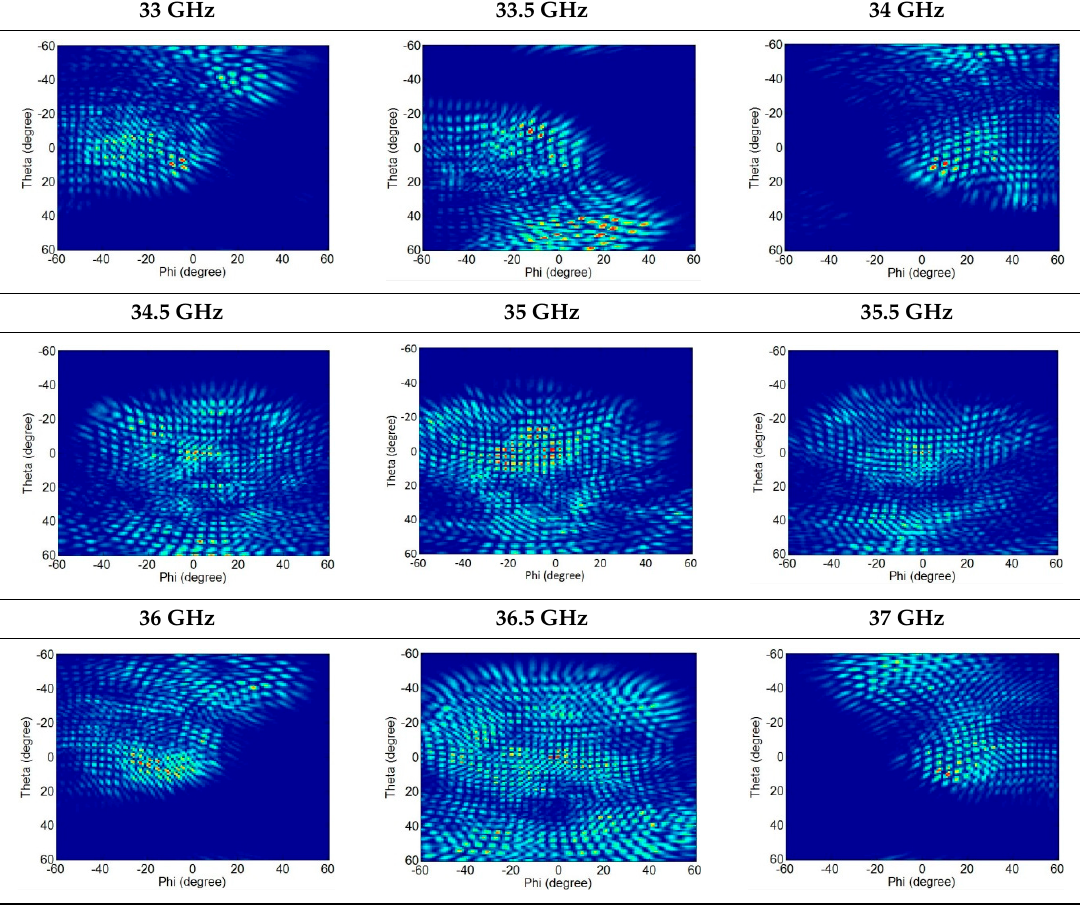
Table 1. Measured field patterns of the metamaterial aperture antenna at different frequencies.